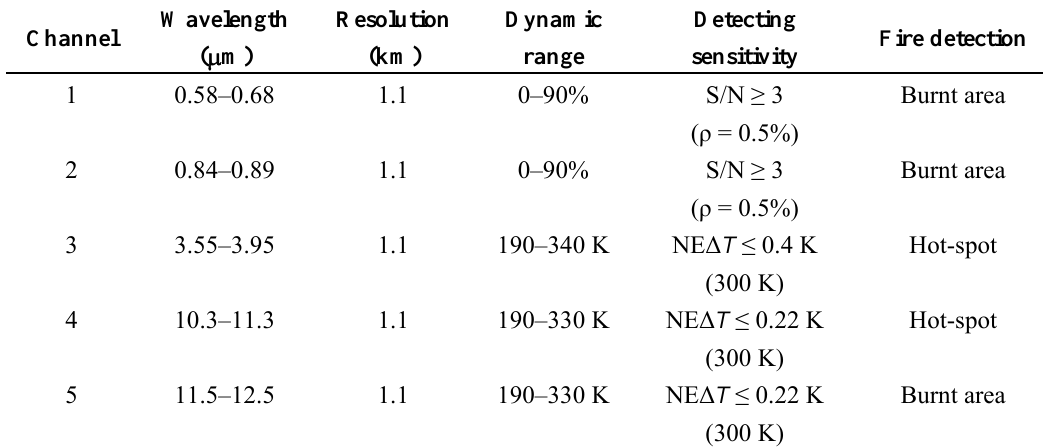
Table 1. The channel characteristics for detecting forest fire by using MVISR sensor onboard FY-1C/1D